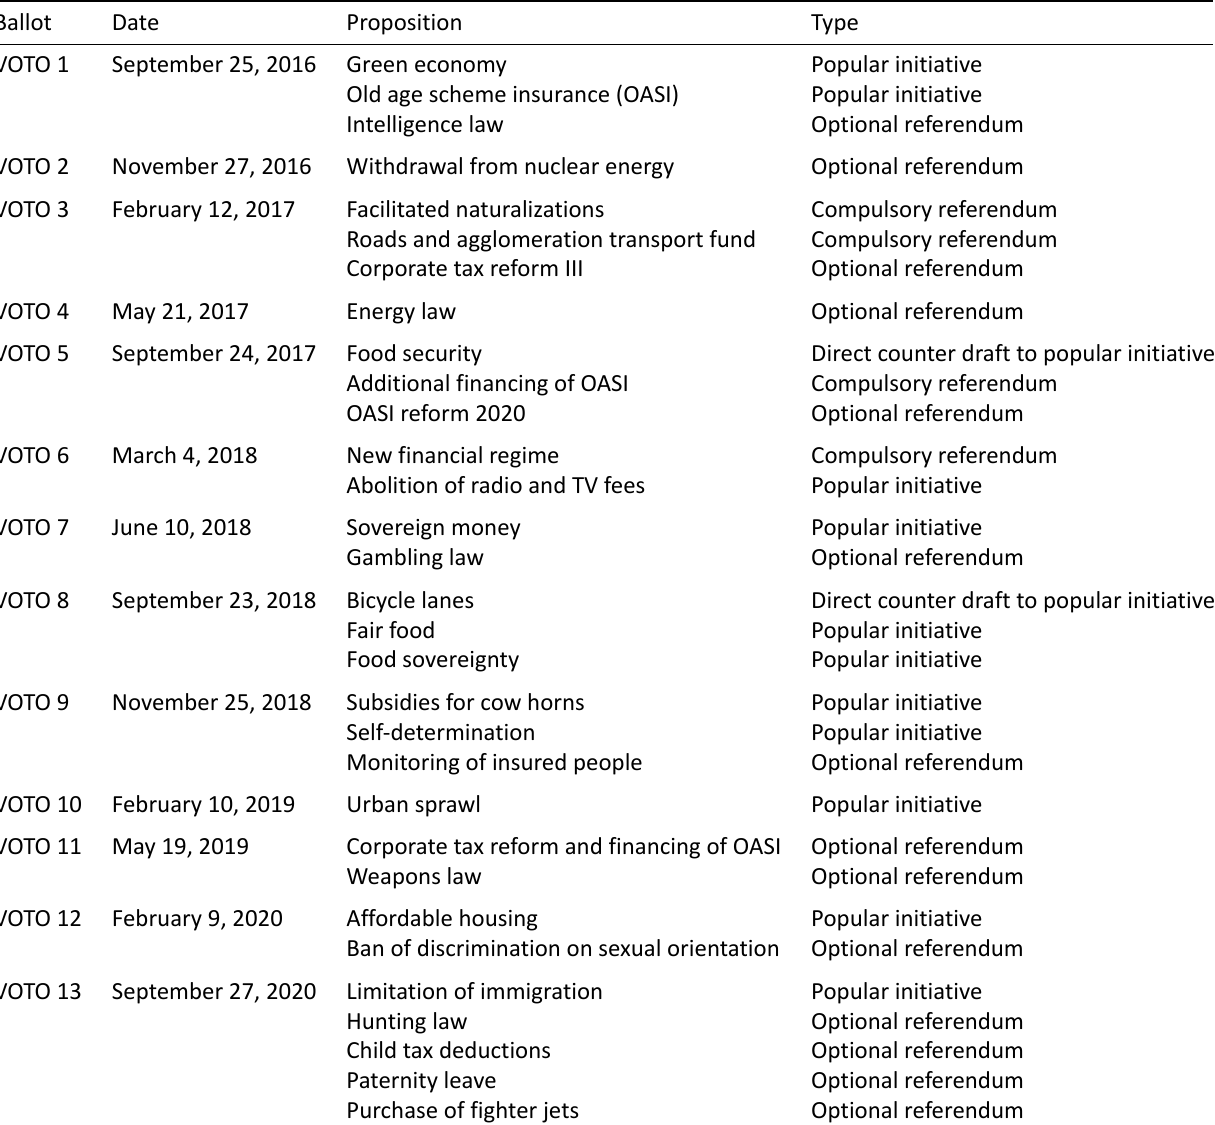
Table 1. Overview of the selected ballots (in chronological order with the submitted